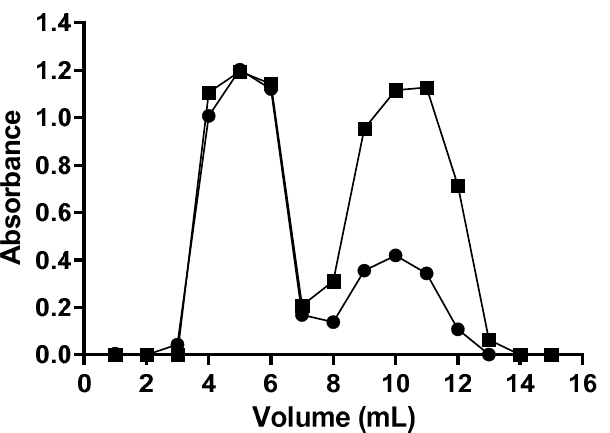
Figure 2. ECONO 10DG column chromatography elution pattern of ASP-ATA and unreacted SATA. ( ● ) absorbance at 280 nm; ( ■ ) absorbance at 238 nm. The results presented are from one representative experiment, among the three independent experiments performed.